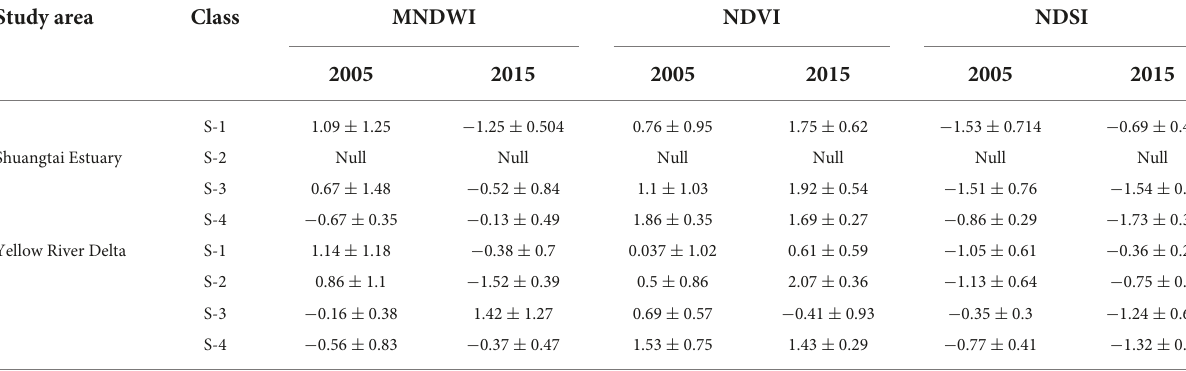
TABLE 8 The spatial accumulation of ecological indicators and the transferred land cover-types in the changing